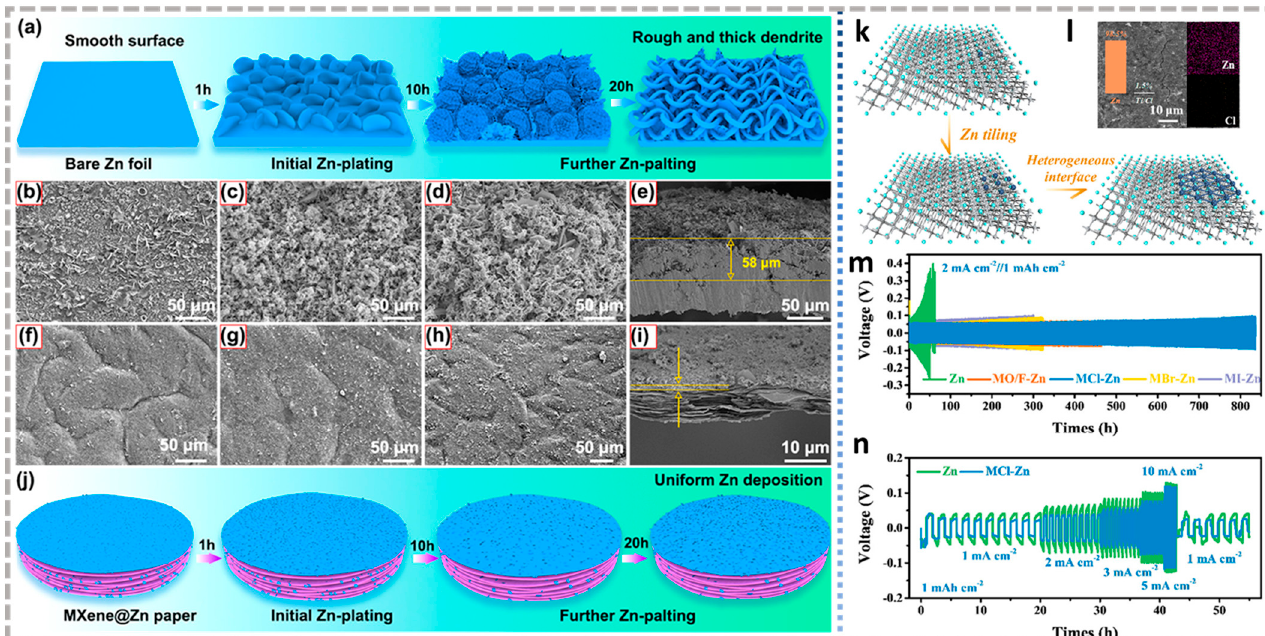
Figure 9. Schematic diagram of Zn deposition on the ( a ) Zn foil and ( j ) Ti 3 C 2 T x MXene@Zn paper; SEM images of Zn deposition after plating capacity up to ( b , f ) 1, ( c , g ) 10, ( d , h ) 20 mAh cm − 2 on Zn foil and Ti 3 C 2 Tx MXene@Zn paper at 1 mA cm − 2 , respectively; Cross-sectional SEM images of ( e ) Zn foil and ( i ) Ti 3 C 2 T x MXene@Zn paper corresponding to d and h, respectively [125]. ( a – j ) Reproduced with permission from ACS Nano. ( k ) Schematic illustration of the Zn deposition process on Ti 3 C 2 Cl 2 ; ( l ) SEM images and EDX mapping of the Ti 3 C 2 Cl 2 -Zn electrode after cycling with a flat and smooth surface; ( m ) Long cycling performance of symmetric batteries; ( n ) Comparison of rate performance of bared Zn metal and Ti 3 C 2 Cl 2 –Zn symmetric ba tt eries with a capacity of 1 mAh cm − 2 [131]. ( k – n ) Reproduced with permission from ACS Nano.